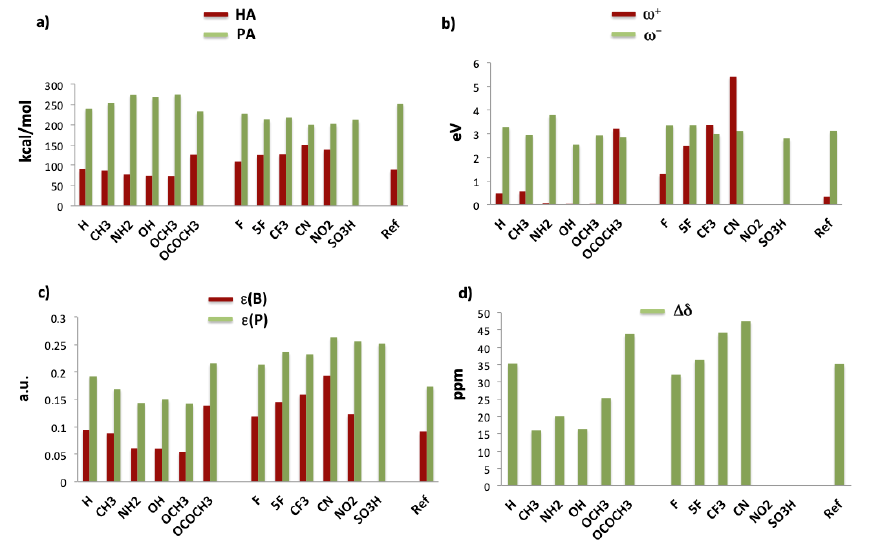
Figure 2. ( a ) Hydride affinity (HA, red bars, absolute values) and proton affinity (PA, green bars), in kcal/mol; ( b ) electroaccepting power ( ω + · 10, red bars) and electrodonating power ( ω − , green bars), in eV; ( c ) boron empty orbital energy ( ε ( B ) , red bars) and phosphorous lone-pair orbital energy ( ε ( P ) , green bars), in a.u. (absolute values); ( d ) variation of the 31 P NMR chemical shift ( ∆ δ ), in